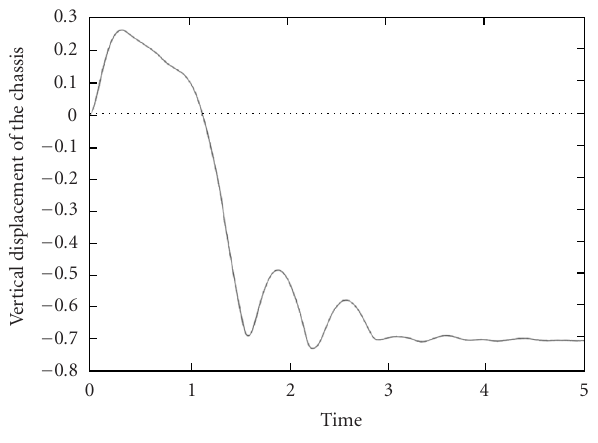
Figure 2.5. The time variation of the vertical displacement of the chassis (m).